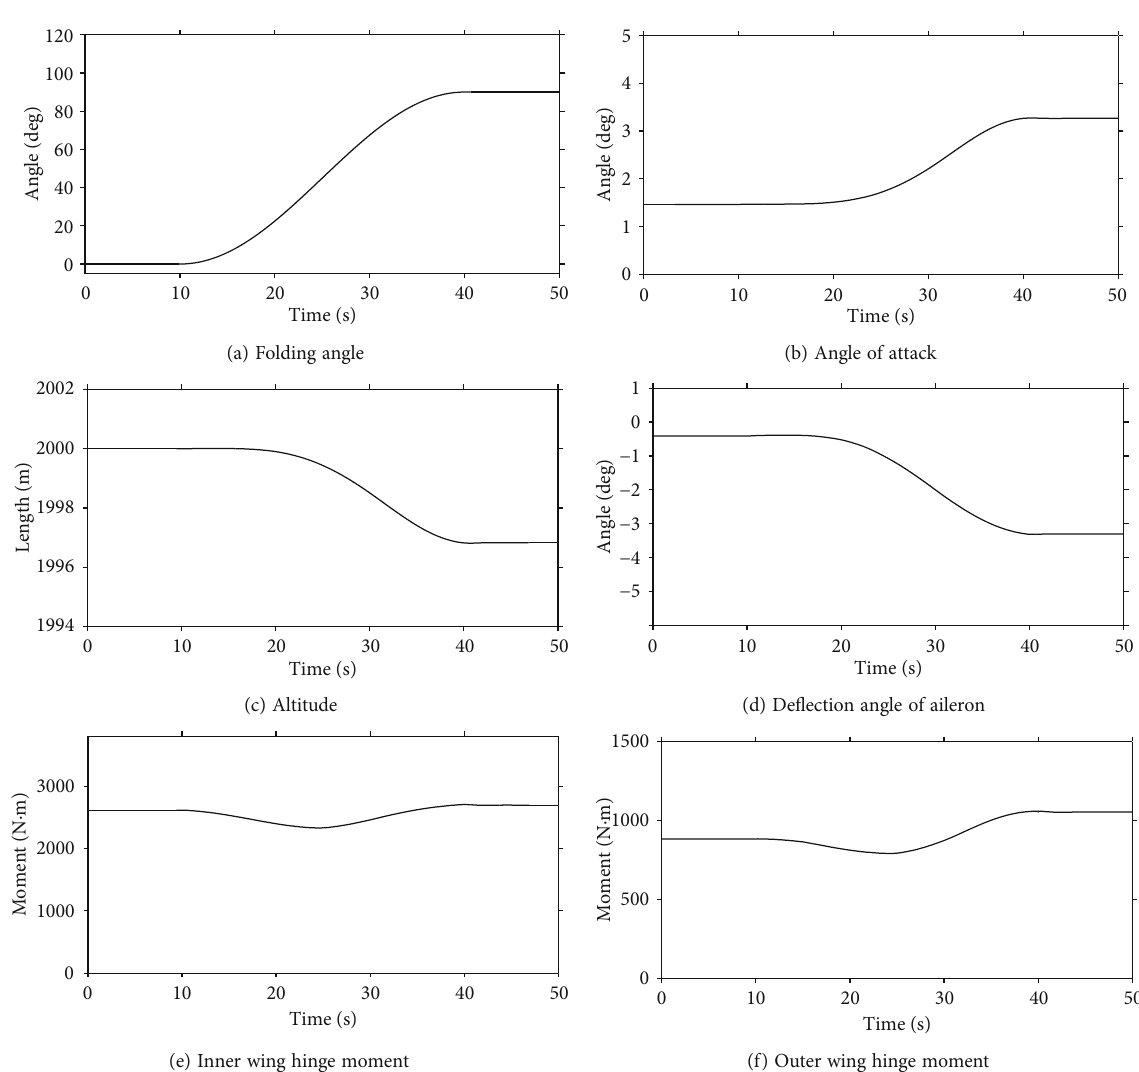
Figure 12: Simulation results based on the CFD aerodynamic